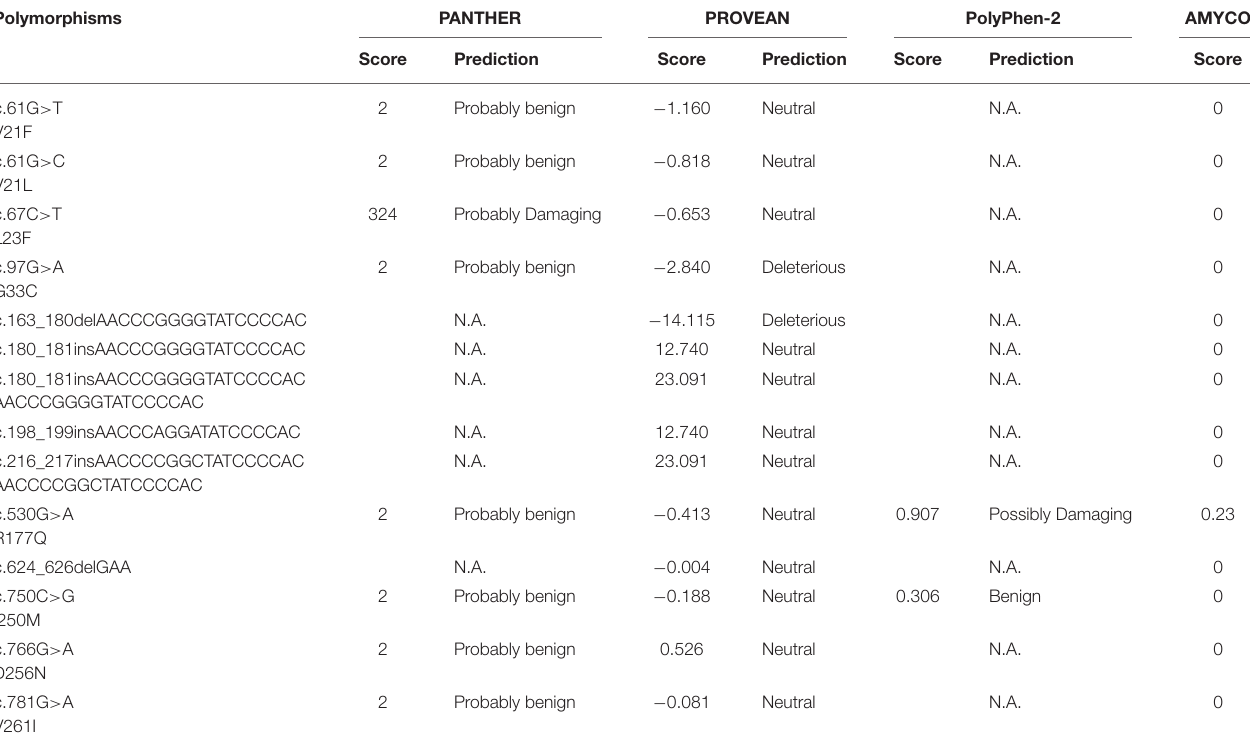
TABLE 4 | In silico evaluation of the effect of PRNP polymorphisms of pheasant prion protein (PrP).